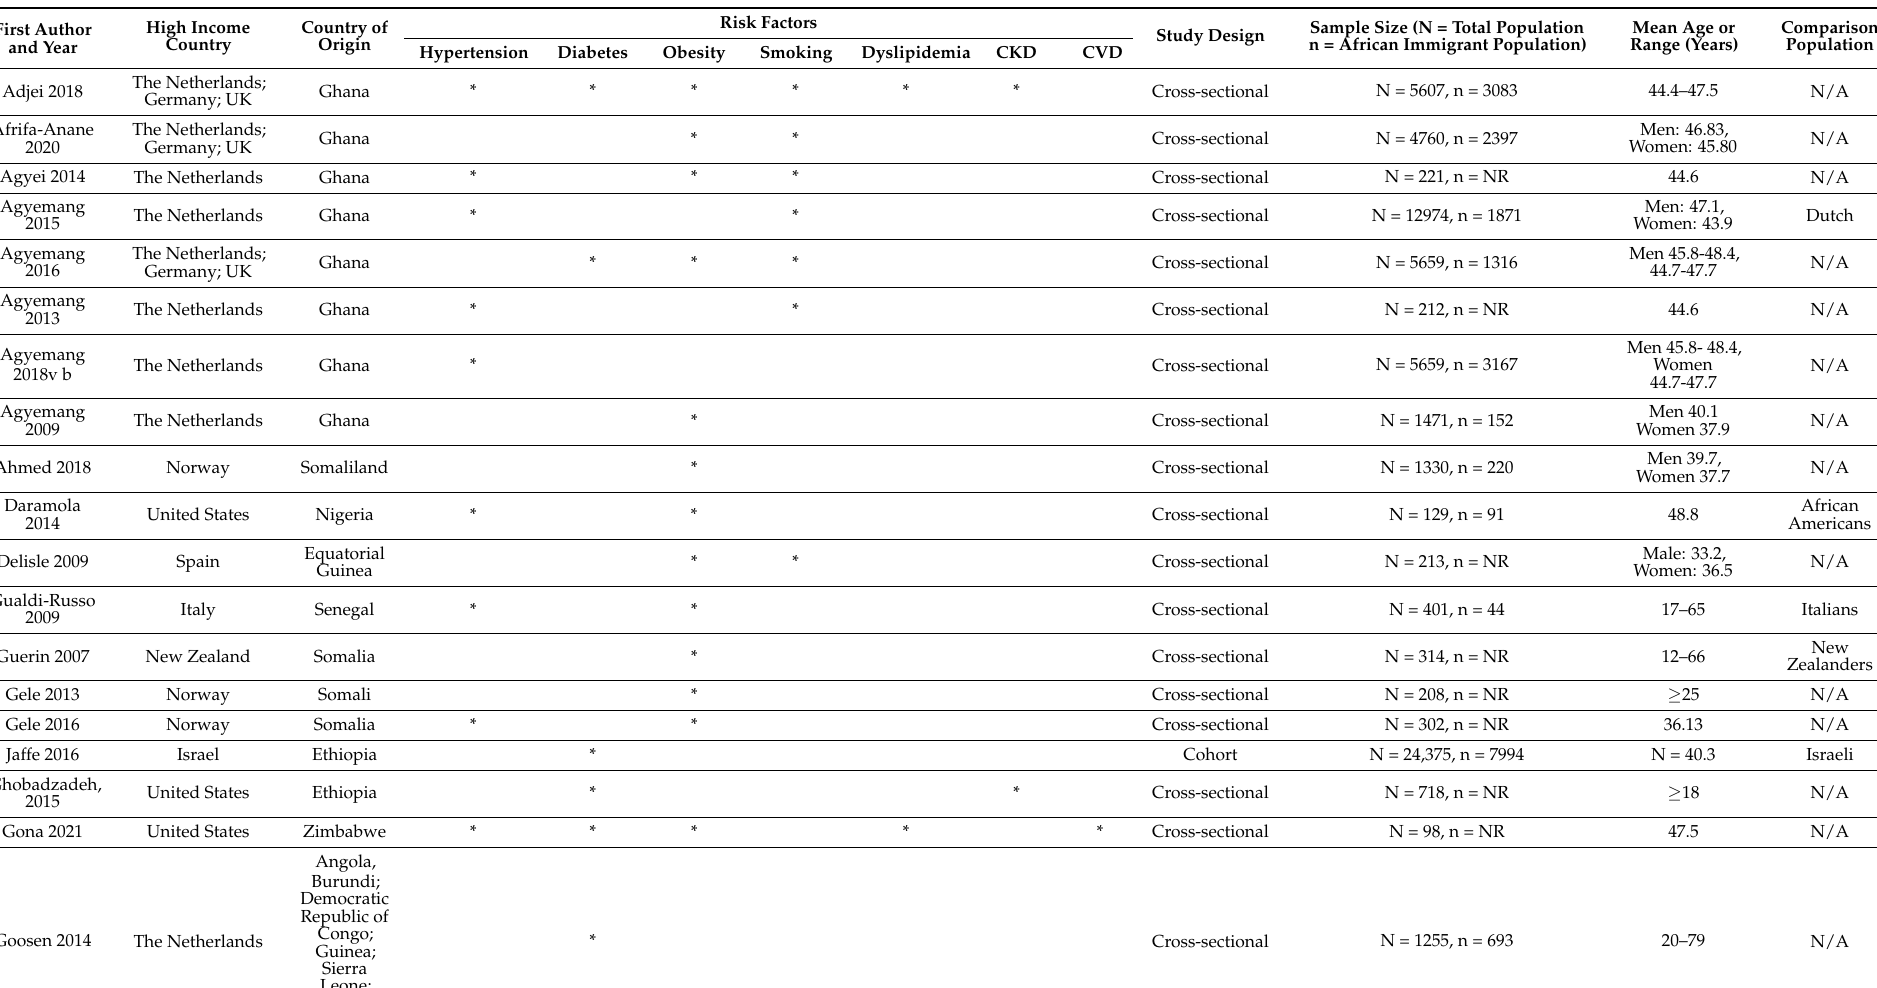
Table 1. Studies examining the cardiometabolic health of African immigrants in high-income countries (N =